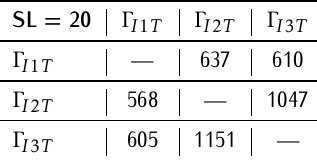
Table 9. Non-unique matching light segments between